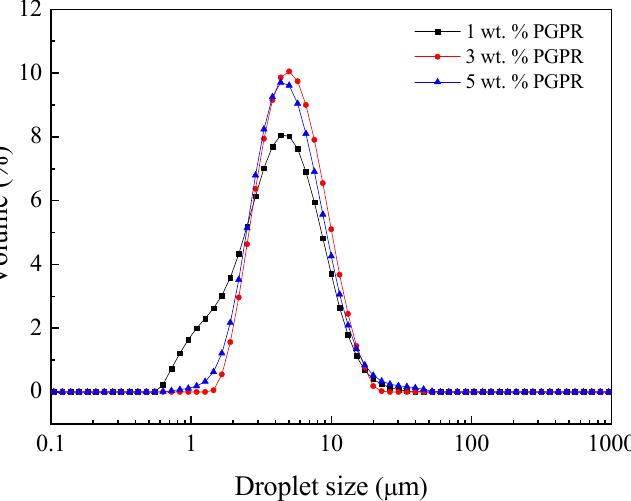
Figure 2. Droplet size distribution of W 1 /O/W 2 multiple emulsions obtained after using 1, 3 and 5 wt.% PGPR for the primary emulsion. 5 wt.% PGPR for the primary